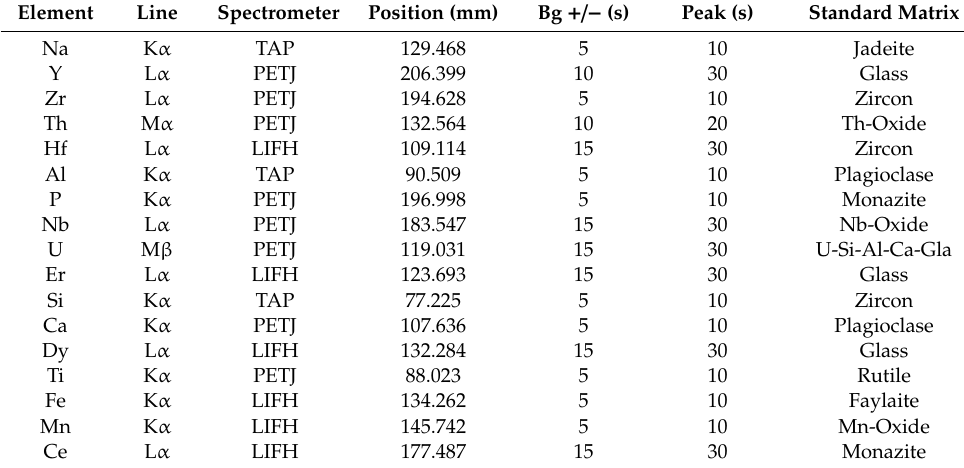
Table A2. Setup for EPMA measurements with focused electron beam on Zr-Silicates and pyrochlore. Sorted according to spectrometer